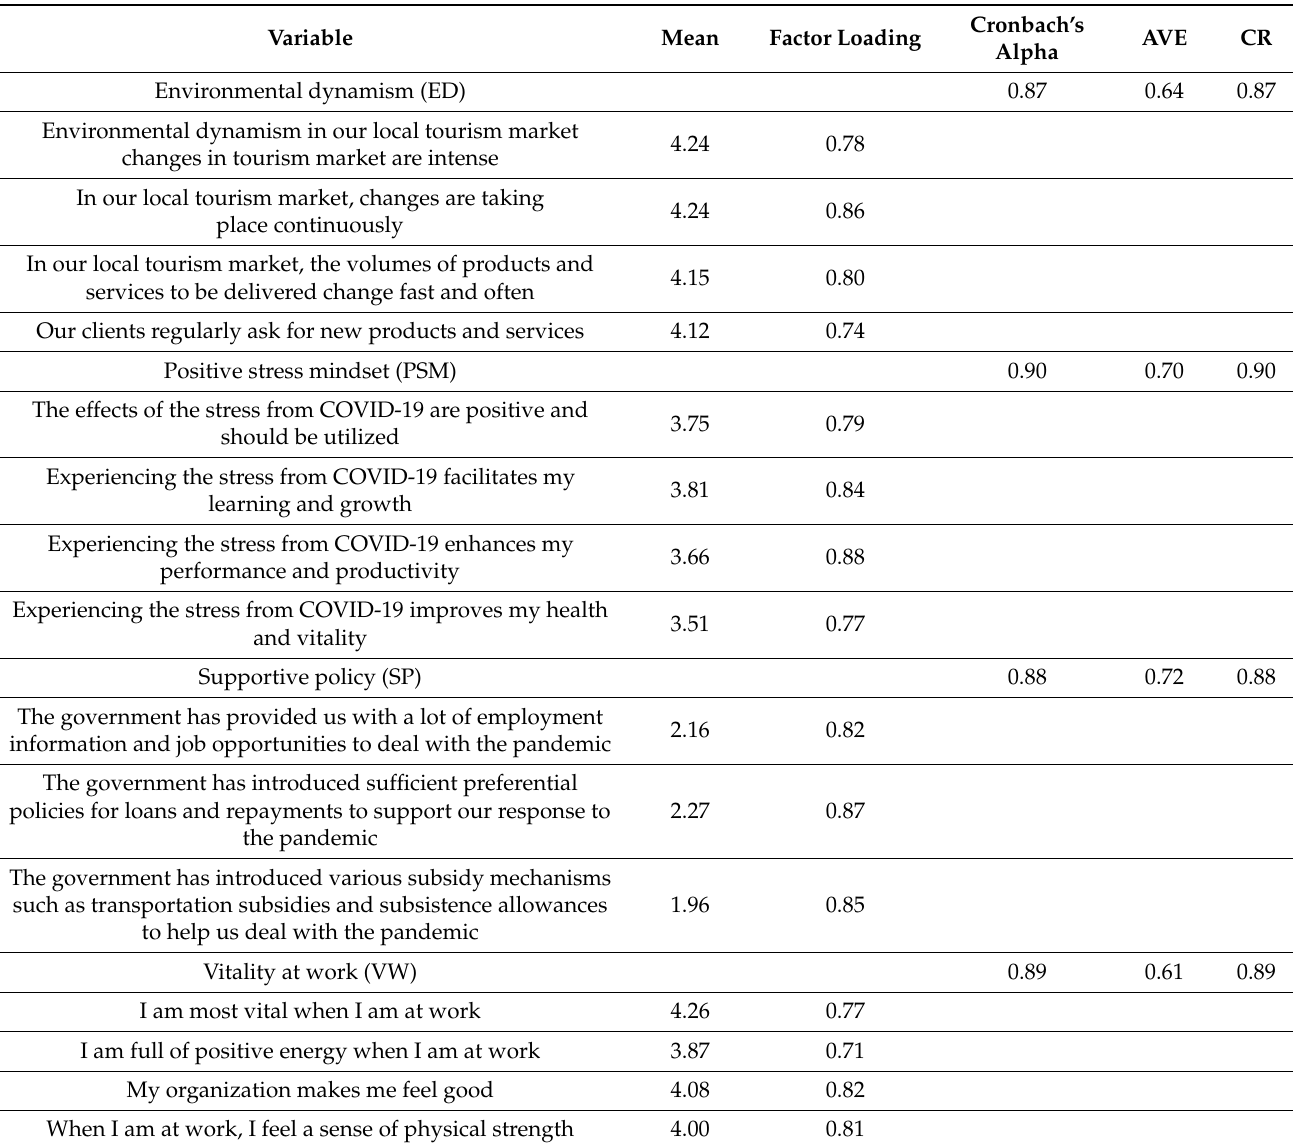
Table 2. Confirmatory factor analysis